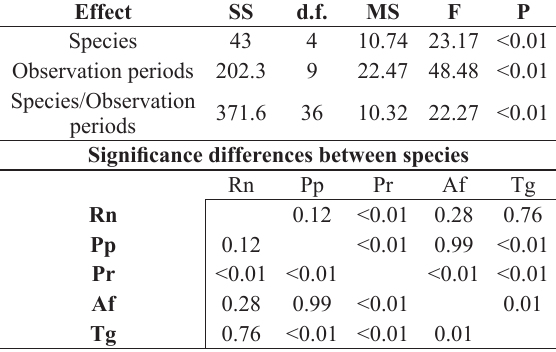
Results of the Factorial Analysis of Variance (ANOVAF) in the visiting frequency of five hummingbird species during ten 50-minute periods of observation of flowers in 10 individuals of the plant Dahlstedtia pinnata